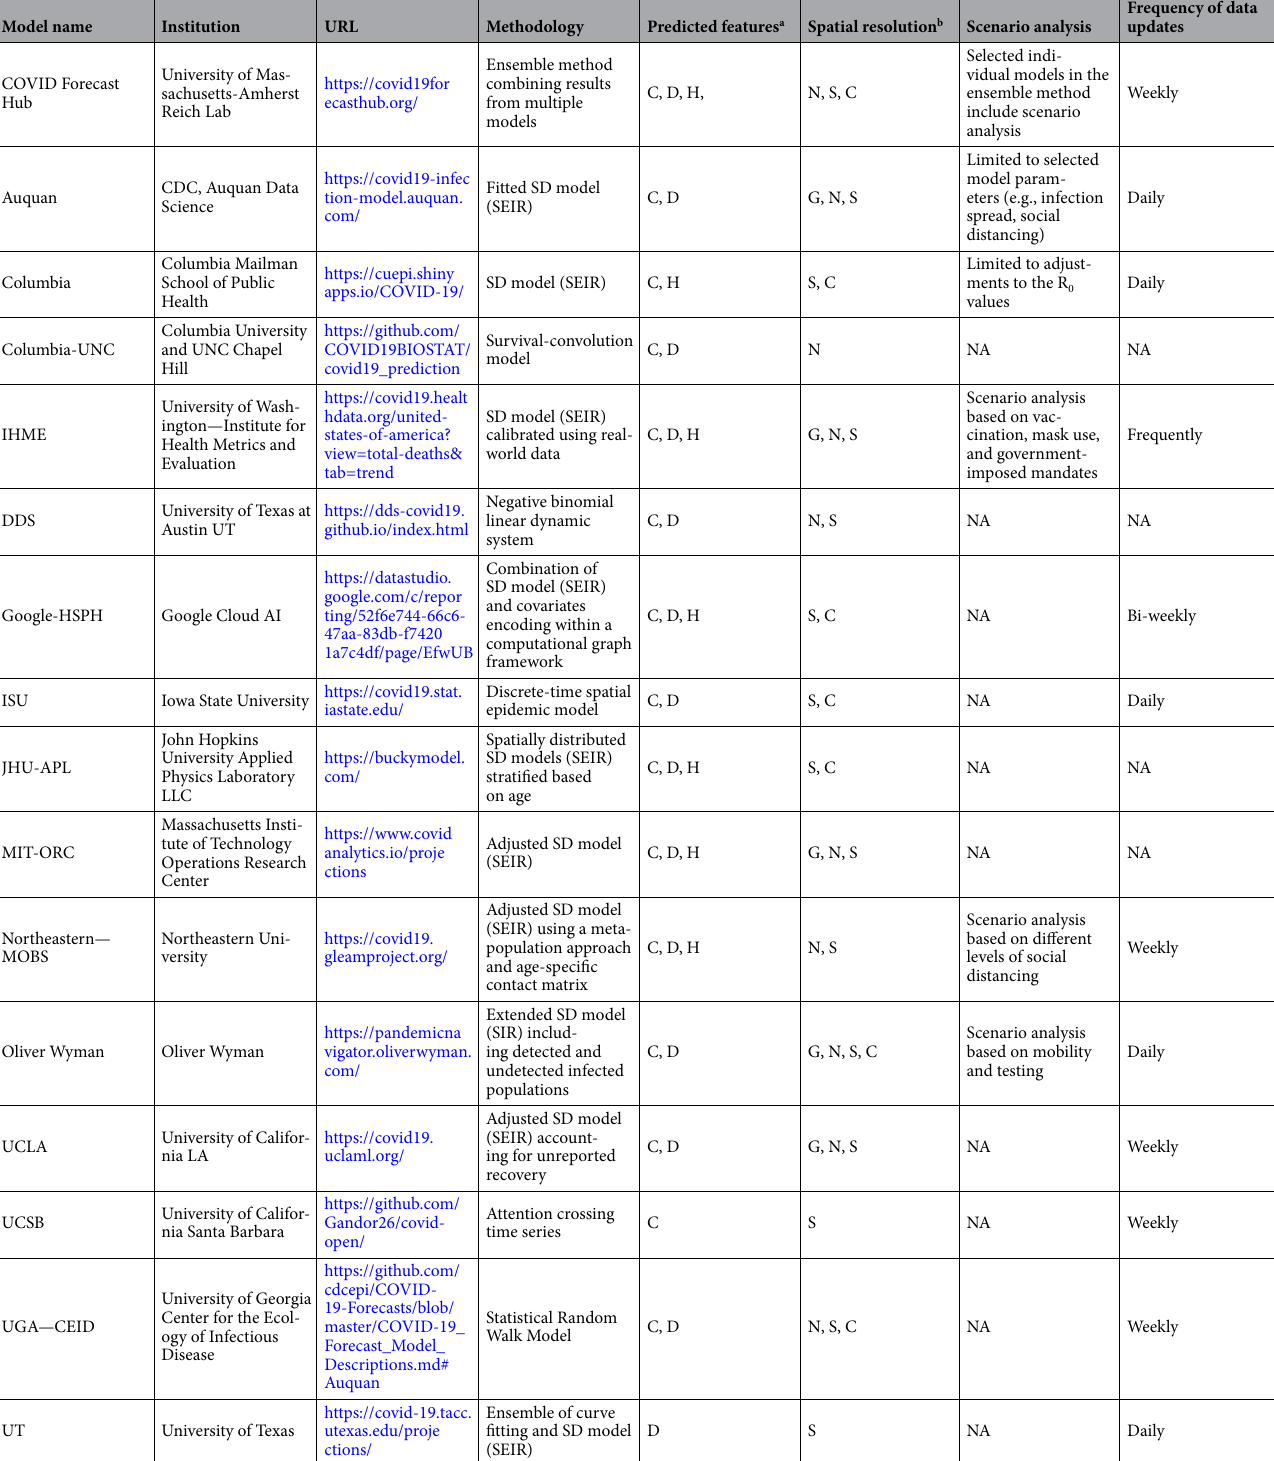
Table 6. Summary of selected COVID-19 models including underlying methodologies, predicted features, spatial resolution, scenario analysis features, and frequency of data updates. a C Case prediction, D death prediction, H hospitalization prediction. b G Global-level predictions (i.e., different countries), N national-level predictions, S state-level predictions, C county-level